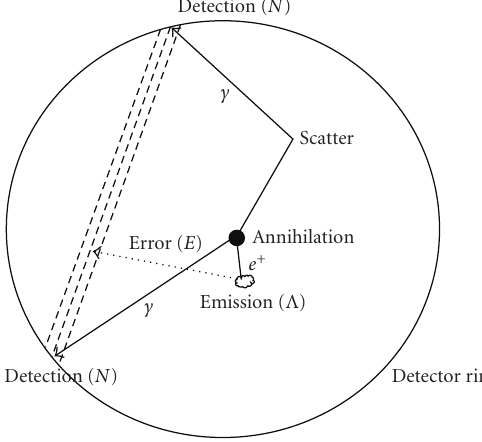
Figure 1: Diagram of PET data